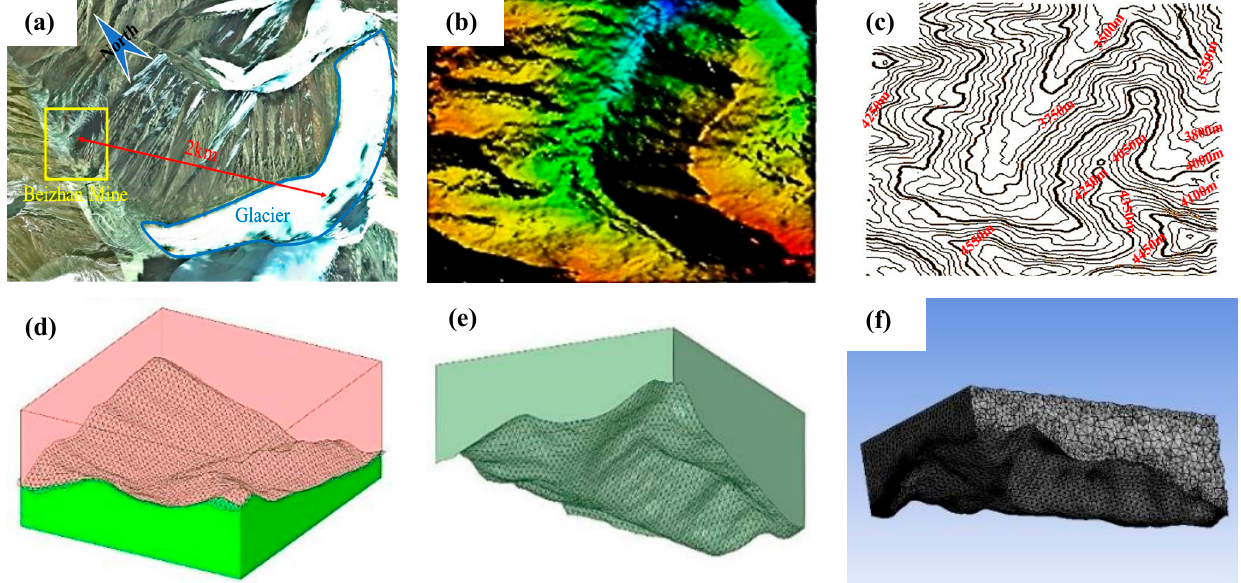
Figure 5. Establishment and meshing of the geometric model. ( a ) Study area. ( b ) DEM data. ( c ) Terrain data. ( d ) Establishment of the model. ( e ) Defining air domain. ( f ) Drawing grids.